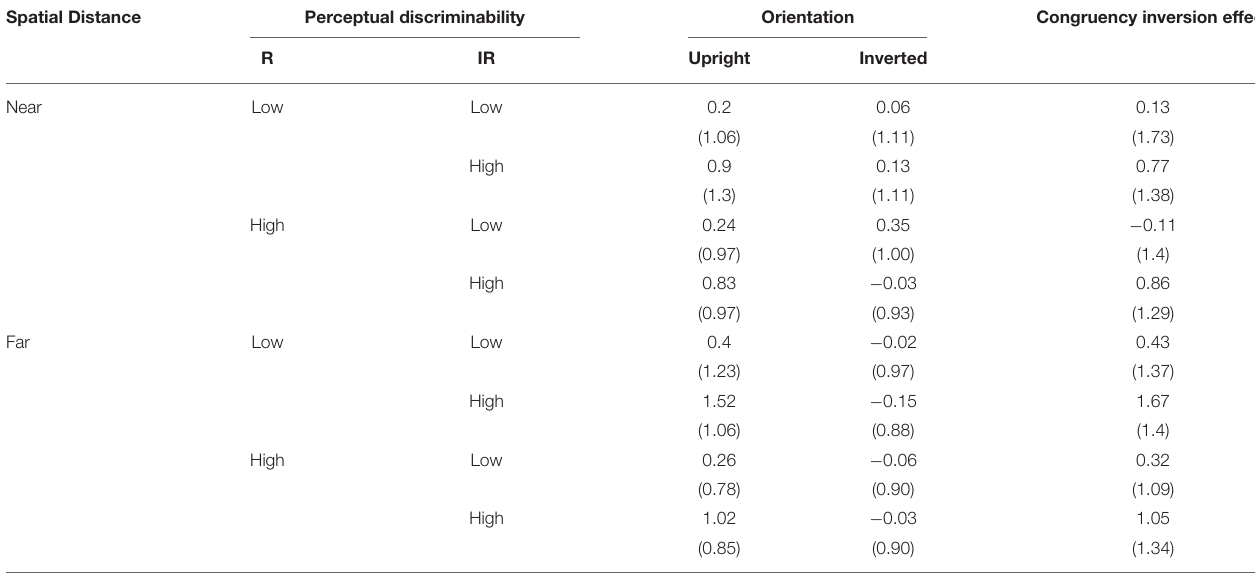
TABLE 4 | The mean congruency inversion effect (d’) for each condition in Experiment 2 ( N = 23) (standard deviations are shown in parentheses). Spatial